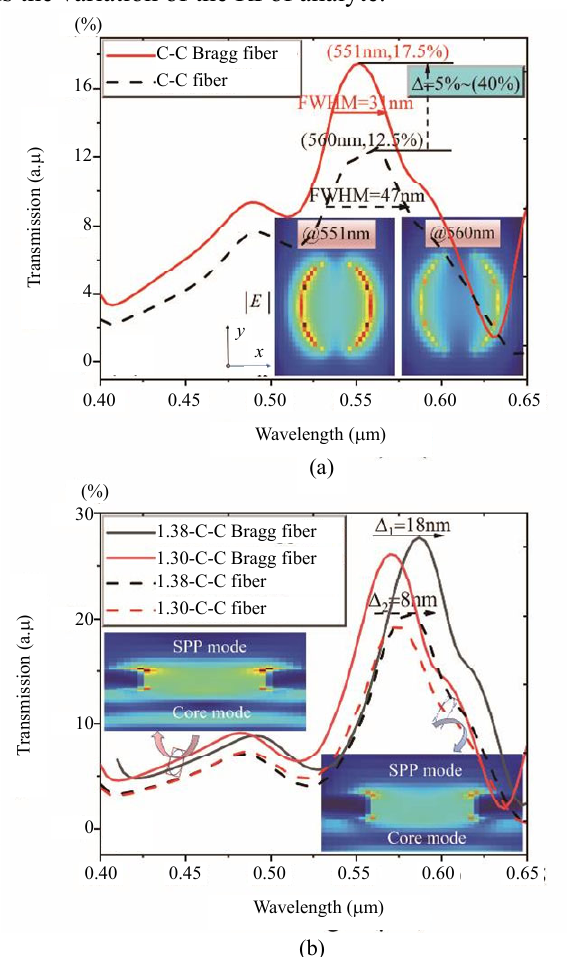
n and eff Fig. 3 Calculated zero-order transmission spectral as a 2 n  function of the wavelength: (a) with C-C Bragg fiber and C-C 1 fiber and (b) for their two different analyte RIs (1.30 and